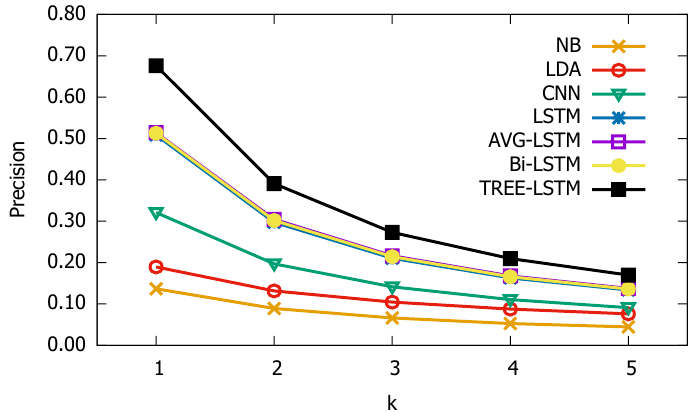
Figure 13. Precision with recommended hashtags range from 1 to 5 in Twitter